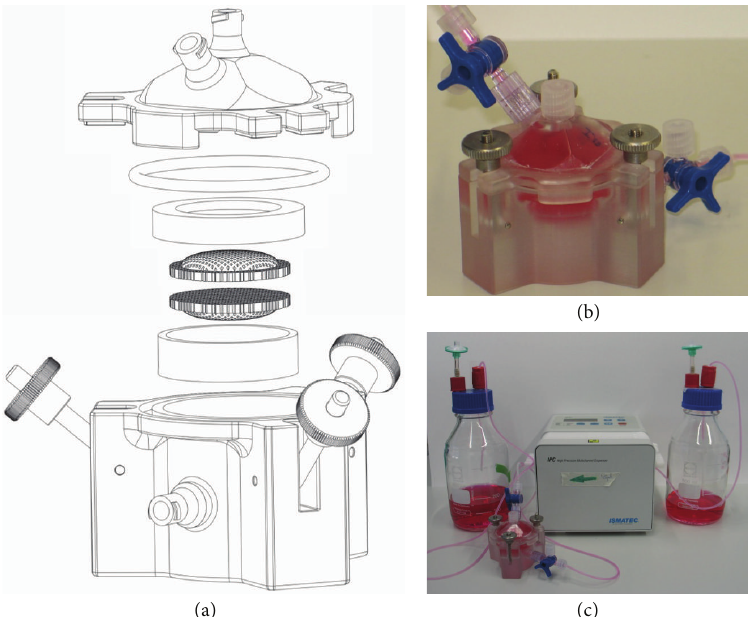
Figure 3: (a) Schematic view and (b) image of the perfusion cell culture reactor “Cellynyzer” with the integrated in vitro 3D module for dynamic cell culture of large scaffolds followed by nondestructive cell analysis. (c) Equipment of the in vitro 3D module: connections to the medium and waste reservoirs and to the peristaltic